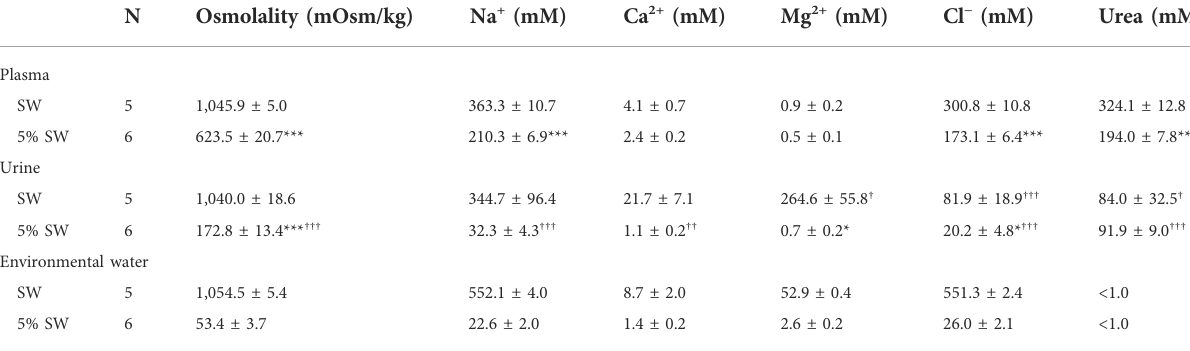
TABLE 2 Compositions of plasma and urine collected from SW- and 5% SW-acclimated red stingray in Experiment 2